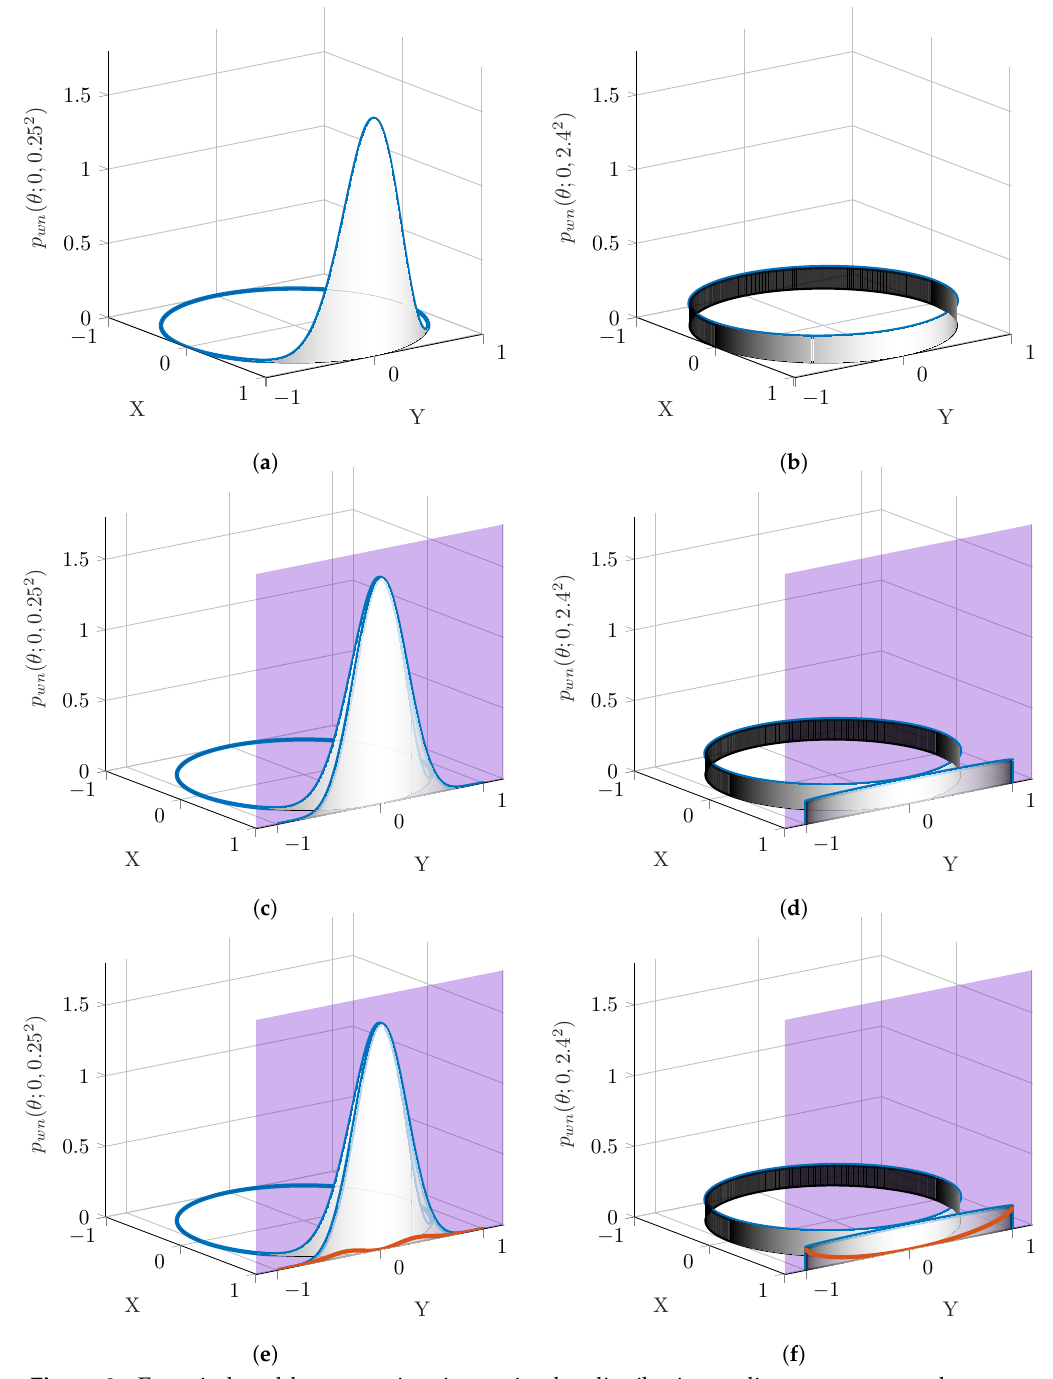
Figure 2. Error induced by approximating a circular distribution as linear, tangent at the mean. ( a ) Wrapped normal distribution with pdf p wn ( θ ;0,0.25 2 ) . ( b ) Wrapped normal distribution approaching wrapped uniform distribution with pdf p wn ( θ ;0,2.4 2 ) . ( c ) Projection of p wn ( θ ;0,0.25 2 ) onto a plane tangent to the unit circle. ( d ) Projection of p wn ( θ ;0,2.4 2 ) onto a plane tangent to the unit circle. ( e ) Error associated with projecting p wn ( θ ;0,0.25 2 ) onto a plane tangent to the unit circle. ( f ) Error associated with projecting p wn ( θ ;0,2.4 2 ) onto a plane tangent to the unit